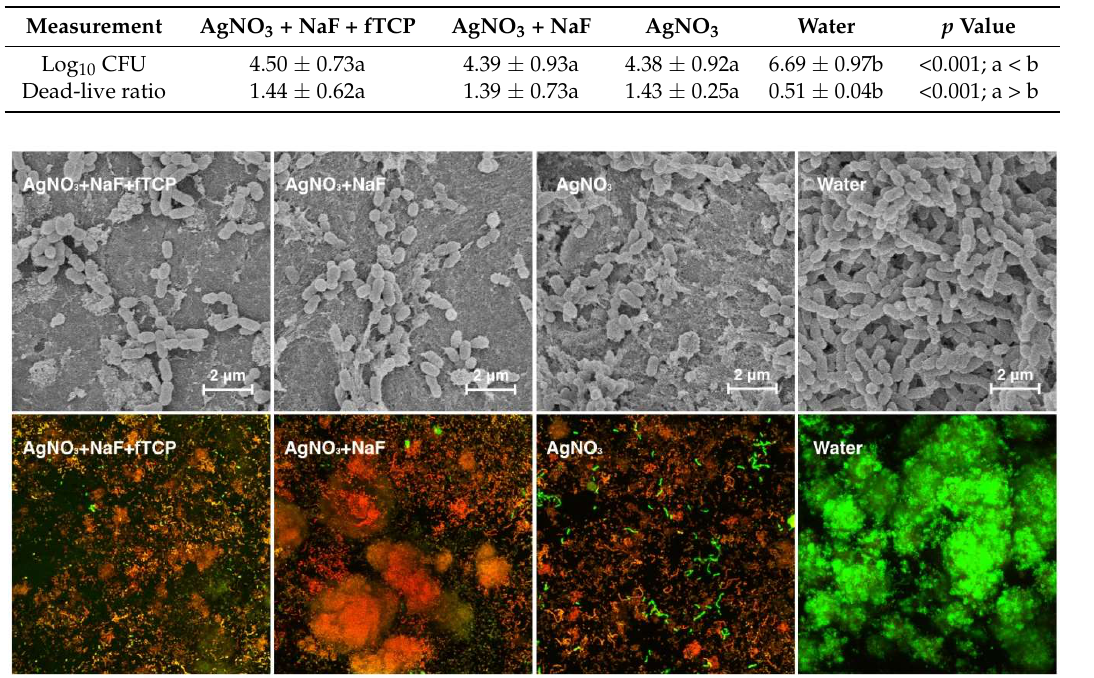
Figure 4. Representative scanning electron micrographs (images in the upper row) of the biofilm topography, and typical images of confocal laser scanning microscopy images (images in the lower row) of the Streptococcus mutans biofilm of the four treatment groups. Dead bacterial cells are marked red, and live cells are marked green (at magnification ×100).